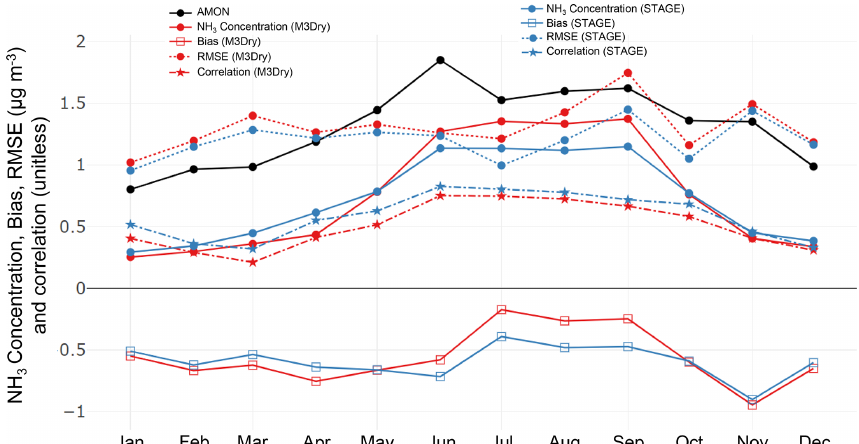
Figure 16. Time series of monthly average observed and simulated NH 3 concentrations (solid circle; µgm − 3 ), bias (open square; µgm − 3 ), RMSE (dotted solid circle; µgm − 3 ), and Pearson correlation coefficient (dot-dashed solid stars) for all AMON sites for CMAQ531_WRF411_M3Dry_BiDi simulation (red) and CMAQ531_WRF411_STAGE_BiDi simulation